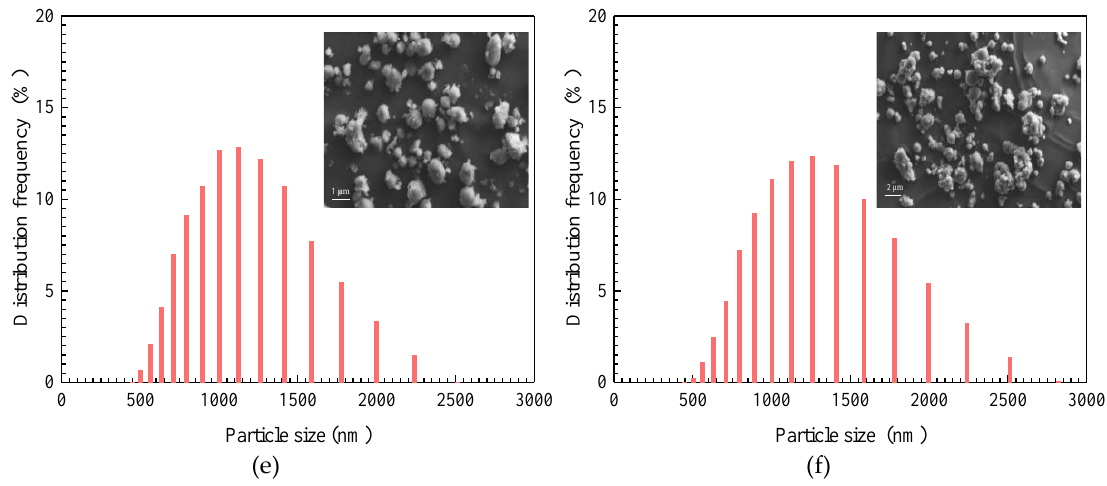
Figure 4. SEM image of SiO 2 /P(MBAAm- co -AM) suspension ( a ); the effect of swelling time on swelling ratio of SiO 2 /P(MBAAm- co -AM) nanoparticles ( b , total dissolved solids (TDS) = 5 g/L, T = 40 °C); and particle size distribution curves of SiO 2 /P(MBAAm- co -AM) nanoparticles in suspension at swelling times of 24 h ( c ), 48 h ( d ), 72 h ( e ), and 120 h ( f ). Insets are the SEM images of SiO 2 /P(MBAAm- co -AM) suspension.